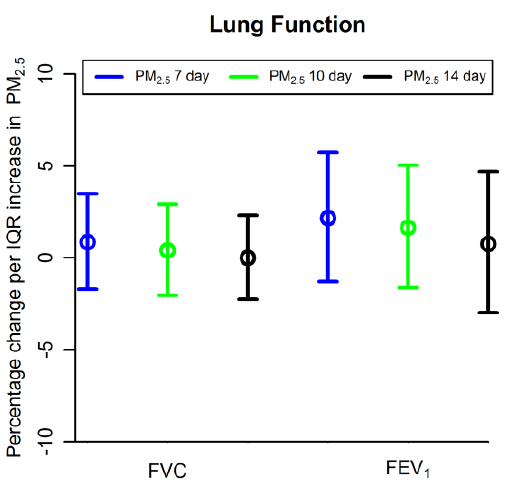
Figure 1. Association between particulate matter (PM 2.5 ) and lung function outcomes. Shown are percentage change of FEV 1 and FVC per interquartile range (IQR) increase in PM 2.5 averaged over 7, 10, and 14 days. FEV 1 : forced expiratory volume in 1 s. FVC: forced vital